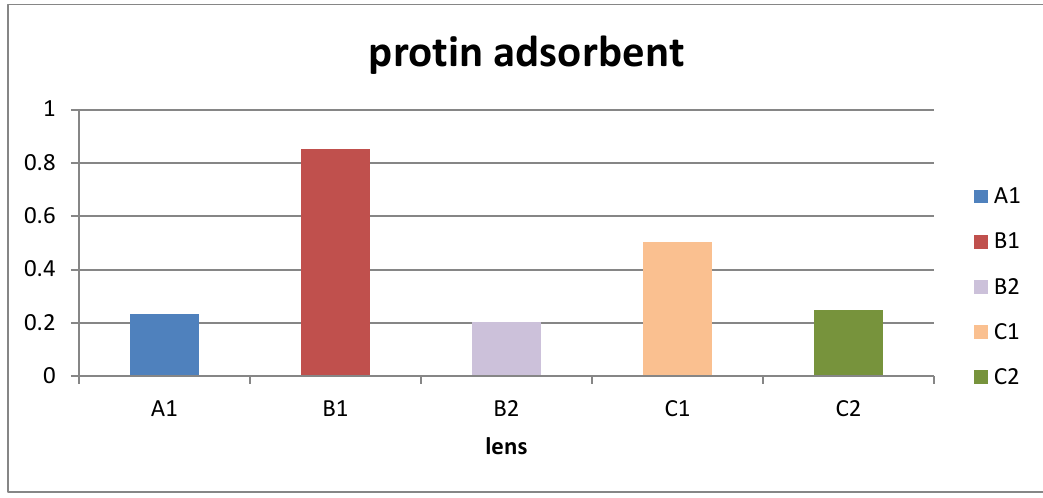
Fig. 16. Effect of Albumin Deposition on Lens